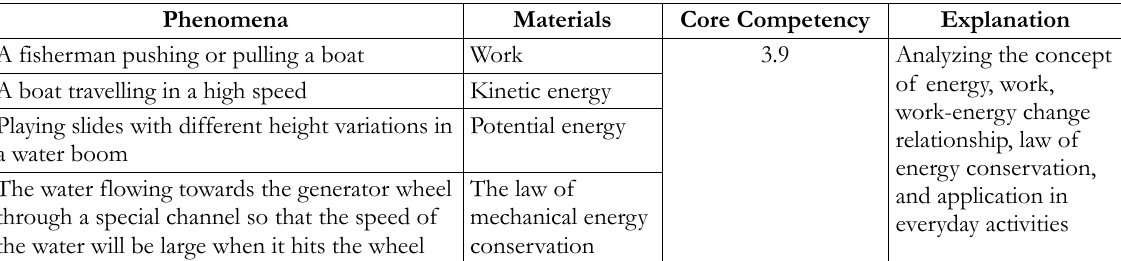
Table 5. Core competencies in Gajah Mungkur Dam